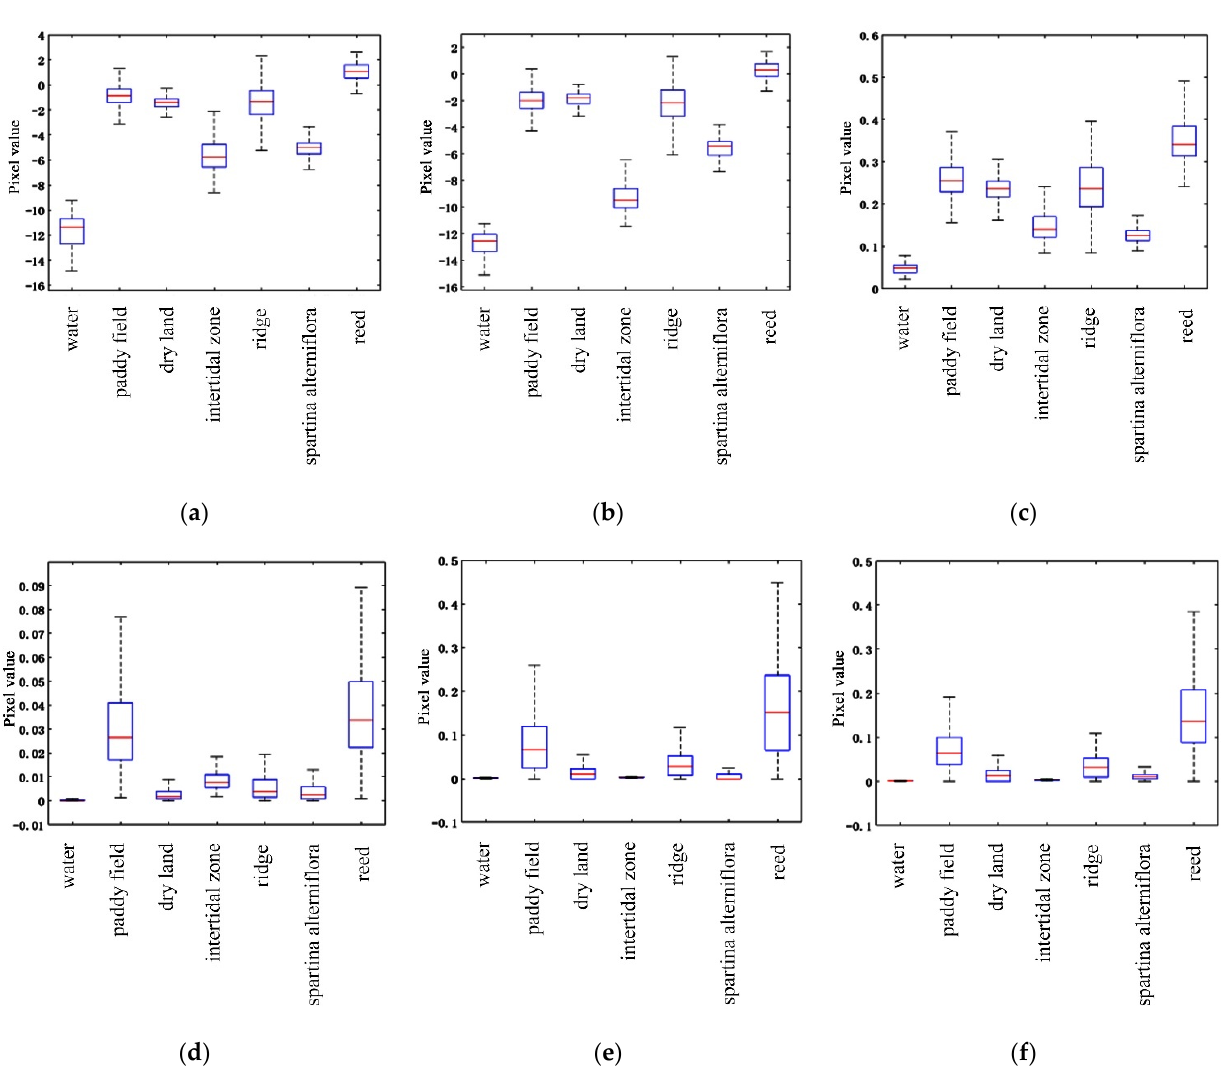
Figure 6. Typical characteristics of different features. ( a ) SE_I feature; ( b ) SE feature; ( c ) Ks feature; ( d ) JRH_T22 feature; ( e ) F_Dbl feature; ( f ) Y_Dbl